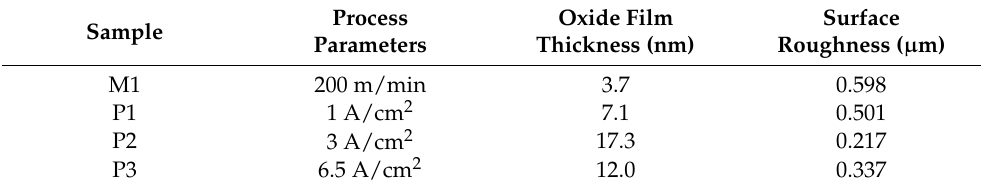
Table 3. Oxide film thickness and surface roughness of test samples.